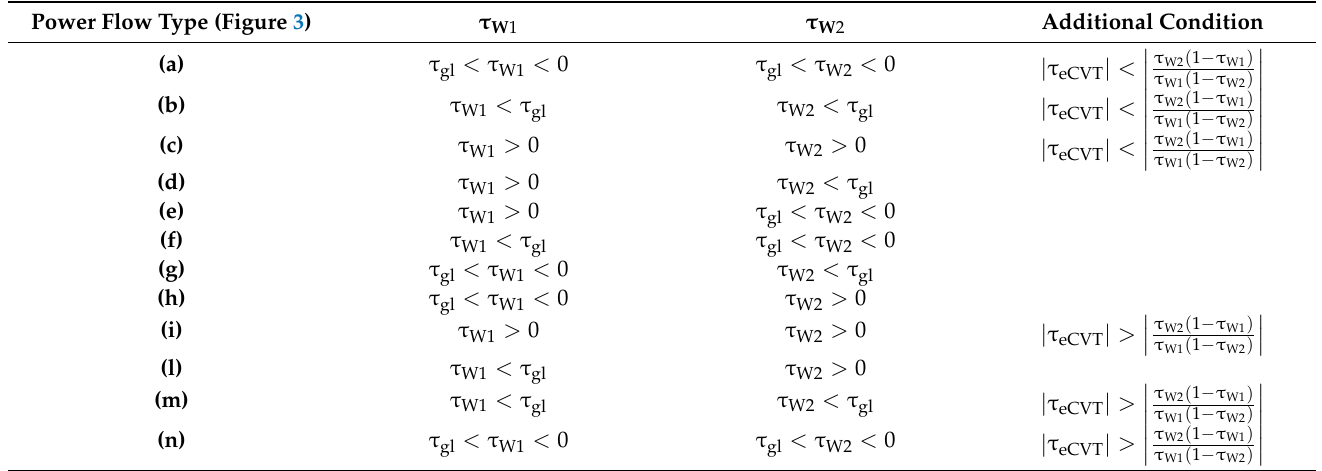
Table 5. Case 2—Conditions for each power